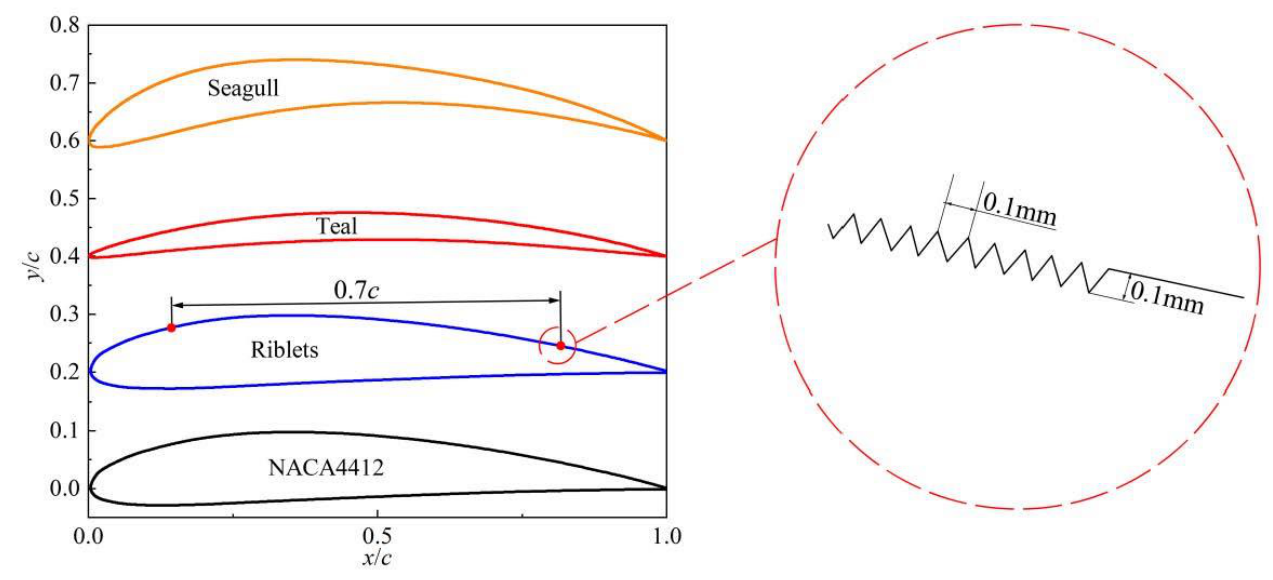
Figure 1. The geometry of the bionic airfoil (NACA4412, Riblets, Teal, and Seagull).